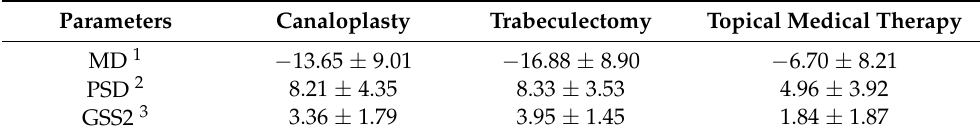
Table 1. Visual field test results in the three different treatment groups.